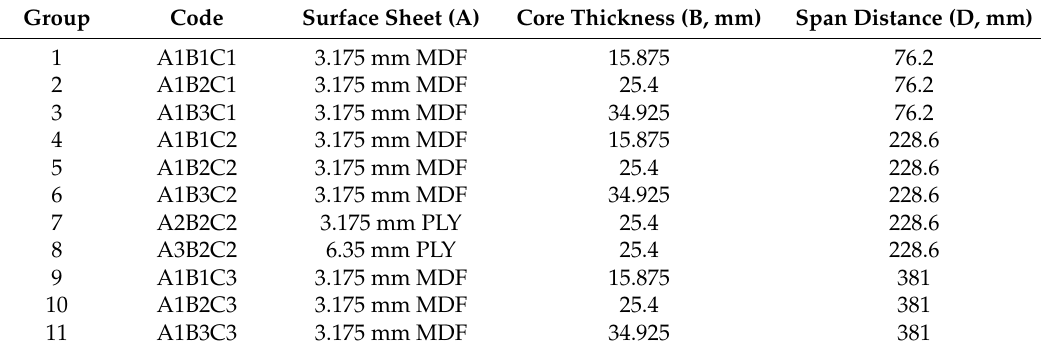
Table 3. Experimental parameter combinations of sandwich beam